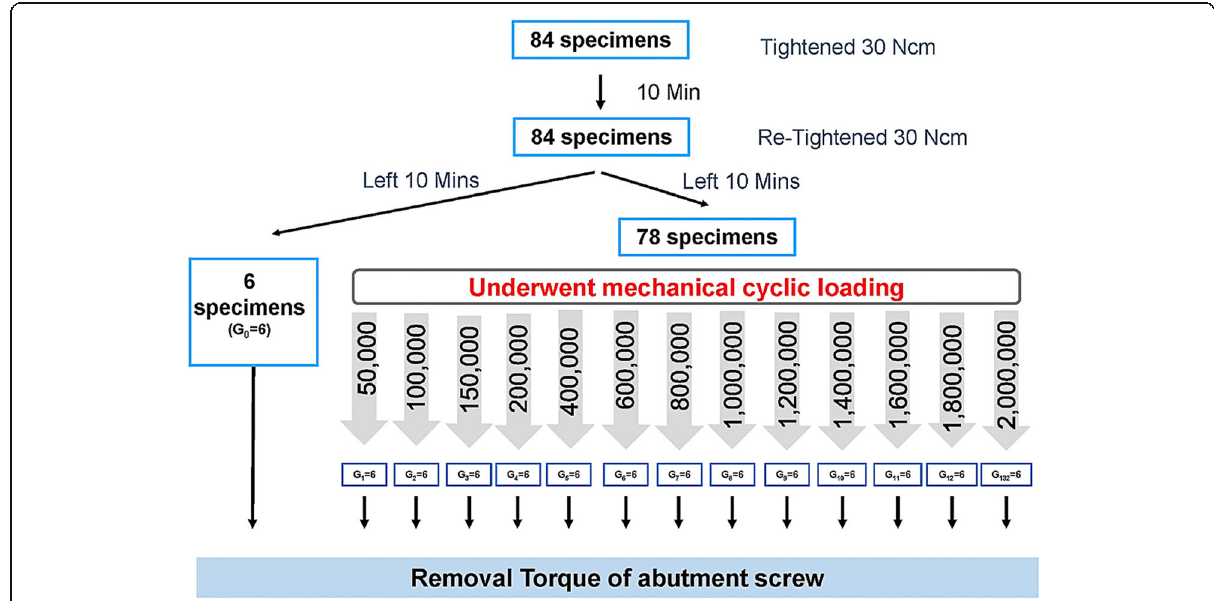
Fig. 7 Schematic diagram for experimental procedure